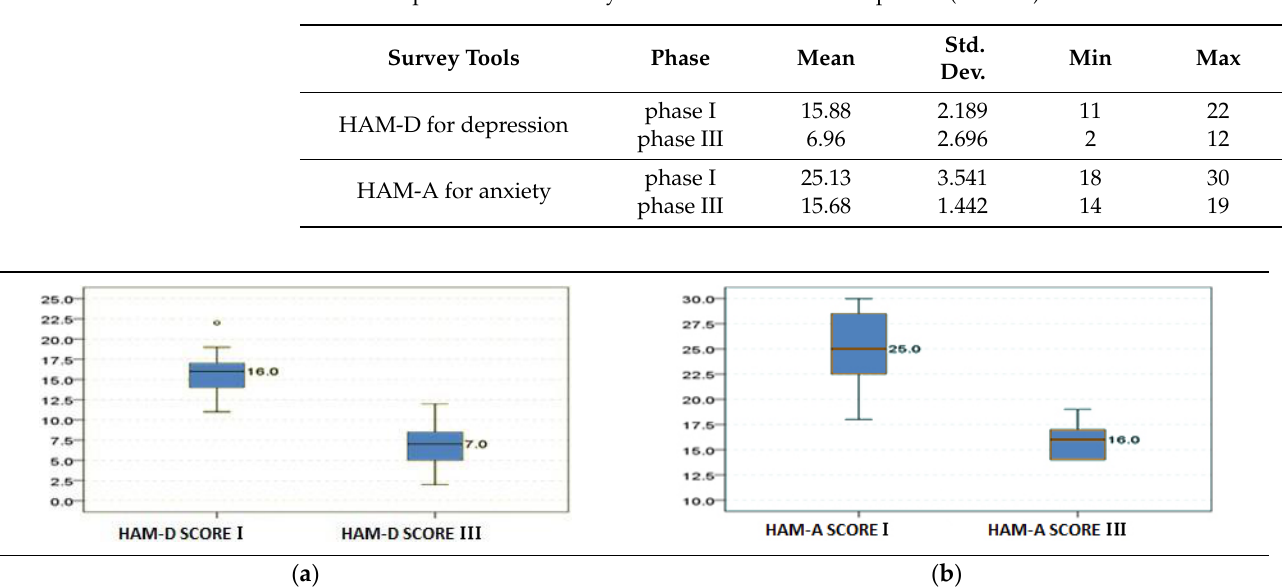
Table 5. Wilcoxon S-R test results–ranks table output.